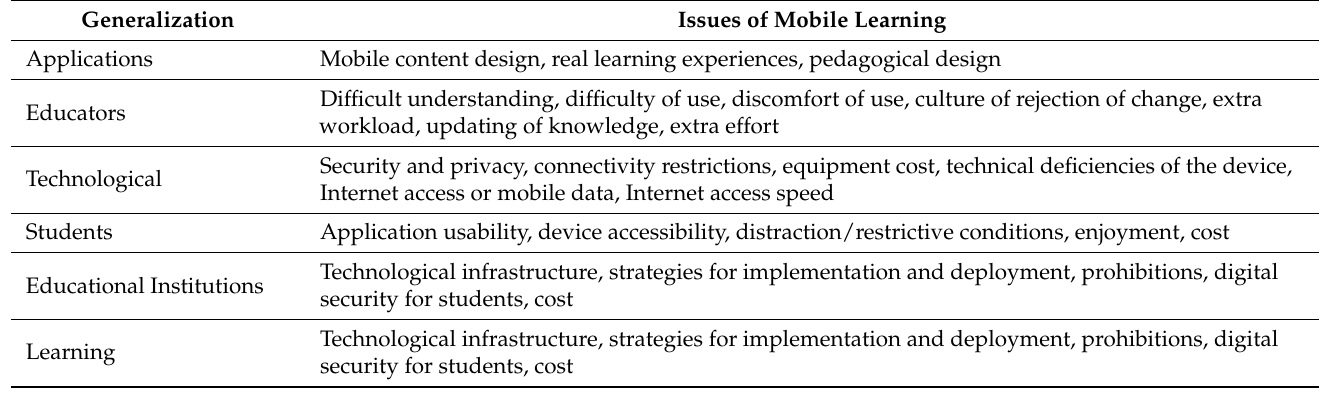
Table 2. Generalization of the issues of using mobile learning in education.